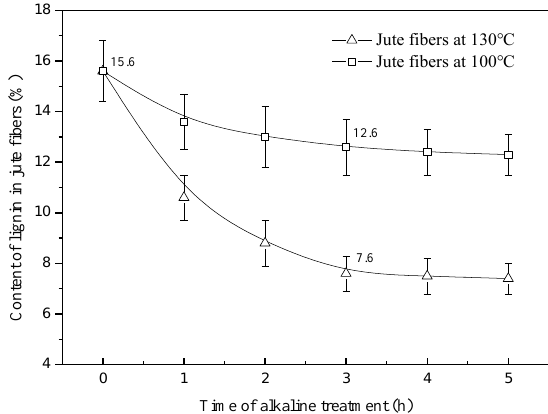
Figure 1. Content of lignin in the jute fibers pretreated at 100 and 130 °C.